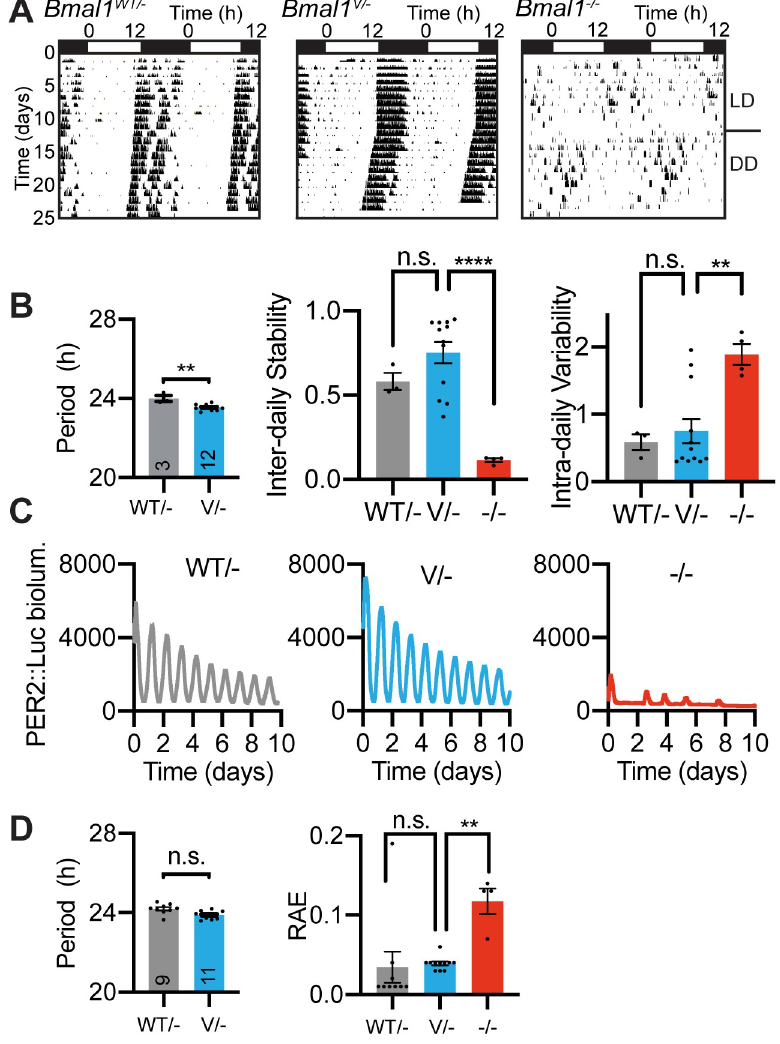
Fig 2. Bmal1 Venus encodes a Venus::BMAL1 protein with complete circadian functionality. A) Representative double-plotted actograms showing effective rescue of the arrhythmic circadian behaviour of Bmal1 null (-/-) mice by a single Bmal1 Venus allele (V/-), which is functionally comparable to Bmal1 WT (WT/-). B) Left-to-right: Mean ± SEM circadian periods of wheel-running behaviour, inter-daily stability and intra-daily variability (n � 3). The latter two are non-parametric robustness measures. C) Representative PER2::Luc bioluminescence traces showing effective rescue of molecular circadian rhythms in SCN slices from Bmal1 null mice by a single Bmal1 Venus (V/-) allele. D) Mean ± SEM circadian periods of SCN PER2::Luc rhythms and mean ± SEM of RAE robustness measure. Statistics: Ordinary One- way ANOVA for 3 or more groups; 2-tailed, unpaired t-test for comparing 2 groups. used for direct comparison of BMAL1 and PER2 rhythms. Venus::BMAL1 exhibited a clear circadian rhythm (period = 25.64 ± 0.59h; n = 4) (Fig 3F, S4A, S4C and S4D Fig) with a low amplitude (6.64 ± 0.6%; n = 4) similar to that of the SCN. In contrast the PER2::Luc rhythm of the paired explant had a high amplitude (~250%; n = 4), with a very low nadir (Fig 3F and S4C Fig). The Venus::BMAL1 peak occurred ca. 9.4h later than the PER2::Luc peak in hip cartilage (Fig 3F), comparable to the lag observed in the SCN. To test whether the rhythm of endoge- nous BMAL1 expression is cell-autonomous, fluorescence was monitored in dispersed cultures of dexamethasone-synchronised primary chondrocytes from Bmal1 Venus / Venus mice. Single-cell